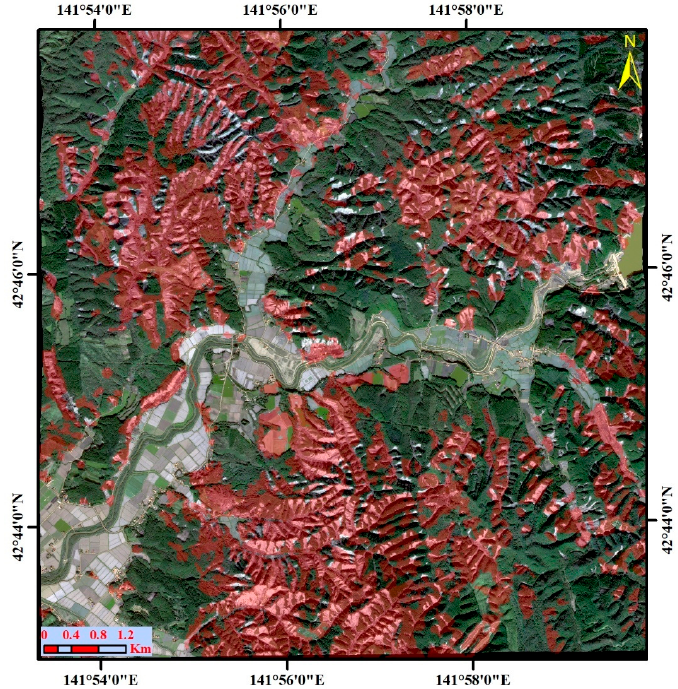
Figure 12. The landslide classification map using the coherence differences in both descending and ascending SAR images (case 4). The background is a GeoEye-1 image taken on 20 October 2018.